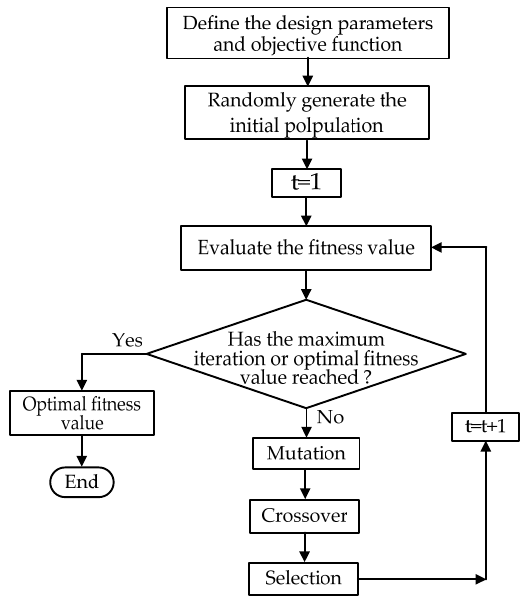
Figure 6. Flow chart of DE